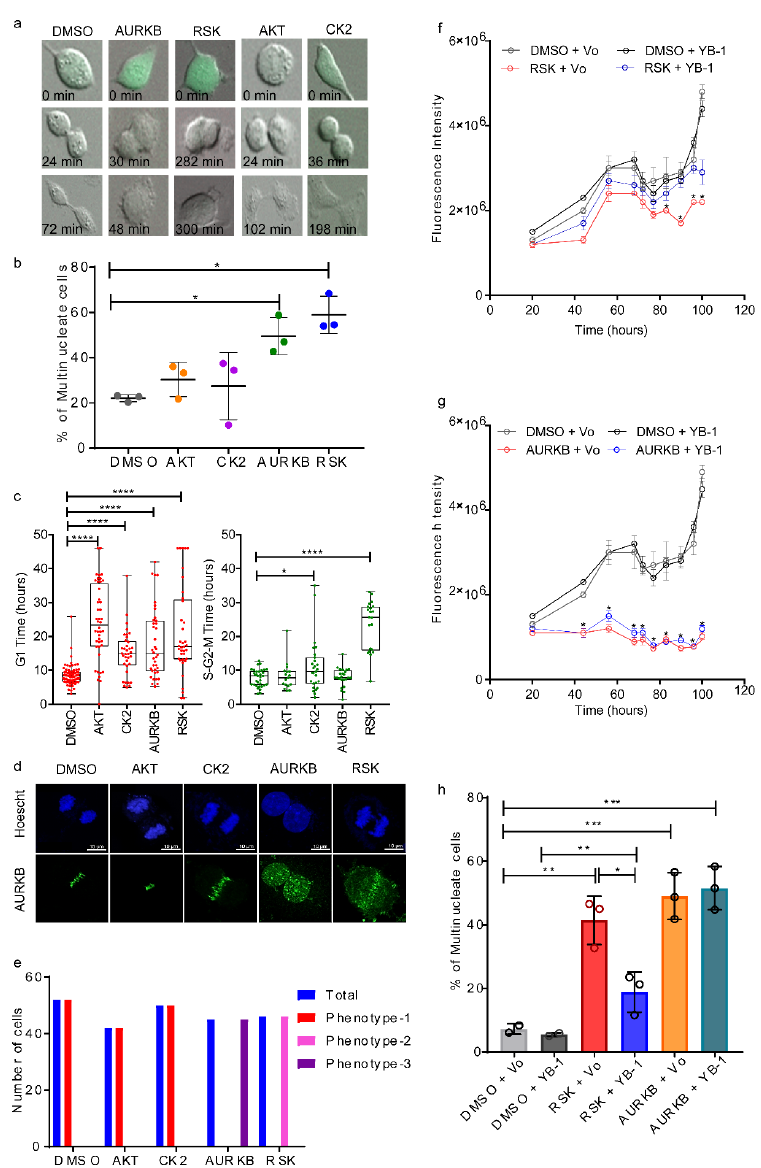
Figure 5. RSK inhibition phenocopies YB-1 depletion. Results from cells treated with solvent control (DMSO), Barasertib-1 µ M (AURKB), BI-D1870-5 µ M (RSK), MK-2206HCl-10 µ M (AKT) or Silmitasertib-10 µ M (CK2). ( a ) Examples of failed cytokinesis after treating A549 / F cells. Images were collected using a 20x objective. ( b ) Percentage of multinucleate A549 / F cells 40 h post treatment. n ≥ 100 cells, three independent image fields, one experiment. Dot plots with lines shown mean ± sd., one tailed student t test, * p < 0.05. ( c ) Distribution of time in G 1 (left) and in S-G 2 -M phases (right) of A549 / F cells post treatment, Mann–Whitney U test, * p < 0.05 and **** p < 0.0001. ( d ) Example of A549 cells post treatment undergoing cytokinesis stained with Hoechst (blue) or anti-AURKB (green). Images were acquired using a 60 × oil-immersion objective. ( e ) Quantitation of AURKB staining at the cleavage furrow in A549 cells; Phenotype1: tightly localized; Phenotype 2: di ff use; Phenotype 3: di ff use nuclear staining. ( f , g ) The amount of SYBR Green I fluorescence over time in cells transfected with Vo or YB-1 EBFP2 and treated with DMSO or BI-D1870 ( f ) or Barasertib ( g ) Each point represents the mean ± s.e.m in ≥ 3 replicates, Student’s t-tests * p < 0.05. ( h ) Percentage of multinucleate cells in A549 / F cells treated with 200 ng of Vo or YB-1 and either DMSO, BI-D1870 or Barasertib for 40 h, one-way ANOVA with Tukey’s multiple comparison test. * p < 0.05, ** p < 0.01, *** p <